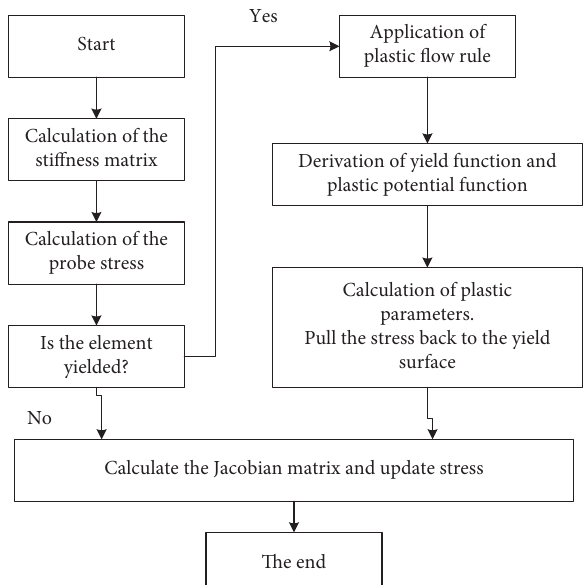
Figure 2: Flow chart of the UMAT used in ABAQUS software.